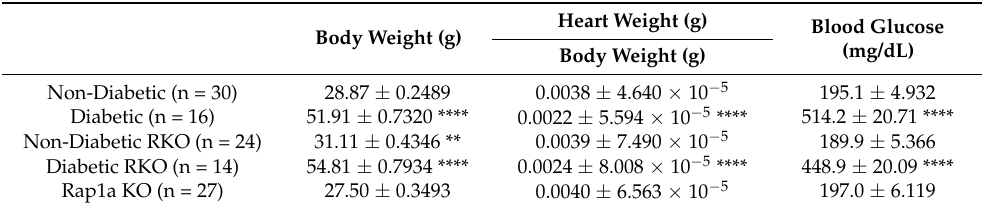
Table 1. Physiology measurements of mice used within this